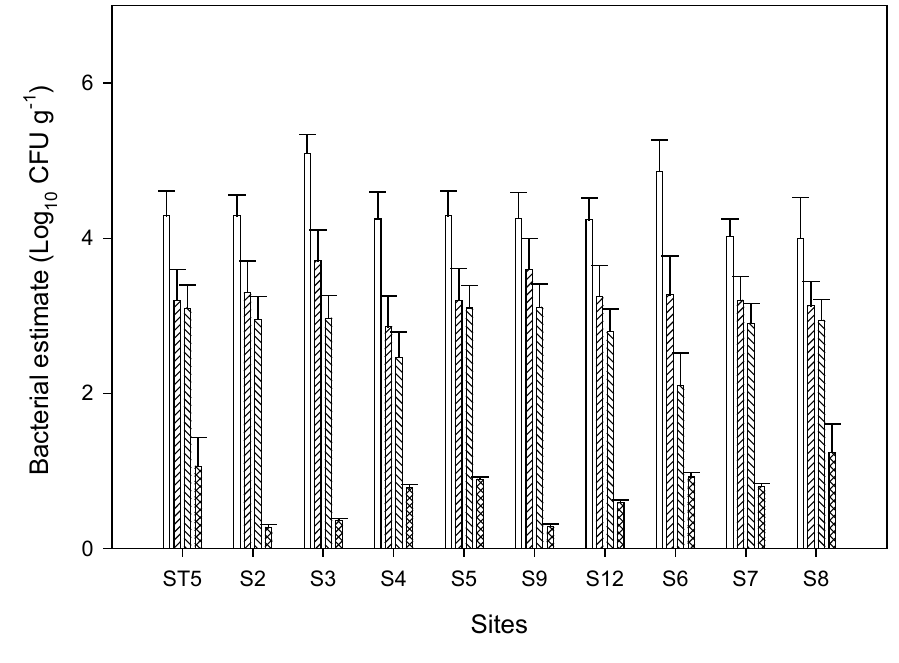
Figure 2. Concentrations of indicator bacteria in sediment on various sampling points along the major sources. Samples ST5, S2, S3, S4, S5, S9, and S12 are from urban runoff and samples S6, S7, and S8 are from agricultural inputs. Symbols ▨ fecal coliform (FC), ▧ E. coli , ▩ pathogenic E. coli . Error bars represent standard errors of three replicate samples. Only samples with potential pathogenic E. coli are